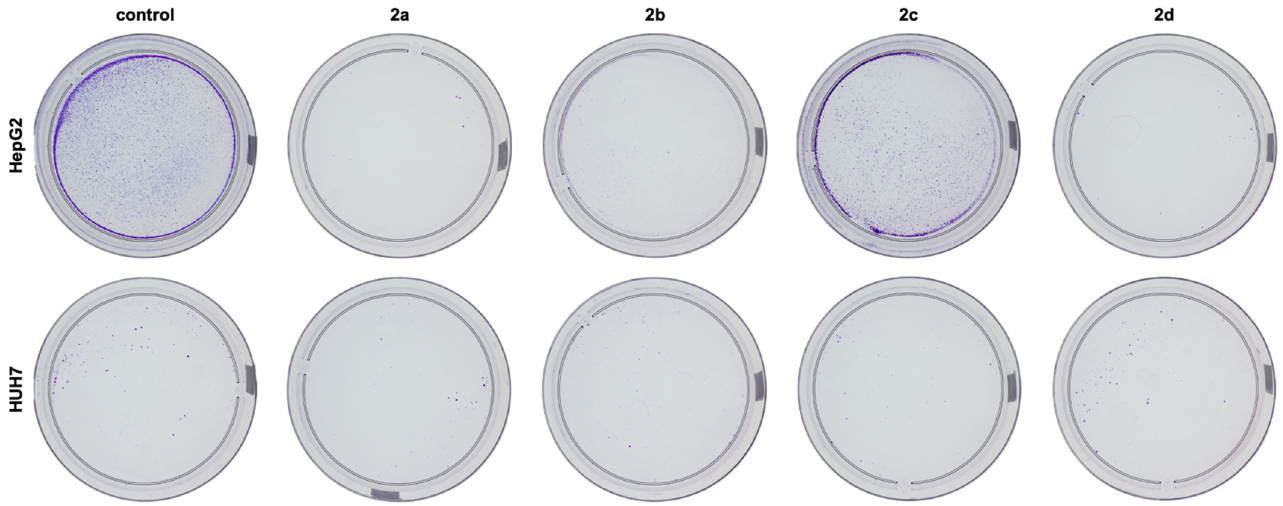
Figure 4. Colony forming ability (clonogenicity) in HepG2 and HUH7 cell lines treated with 2a – 2d at their IC 50 for 72 h. Photographs were taken after staining the cells with crystal violet. After cell fixation and staining with crystal violet, photographs were taken and the obtained data were quantified using ImageJ software (see Table 1).